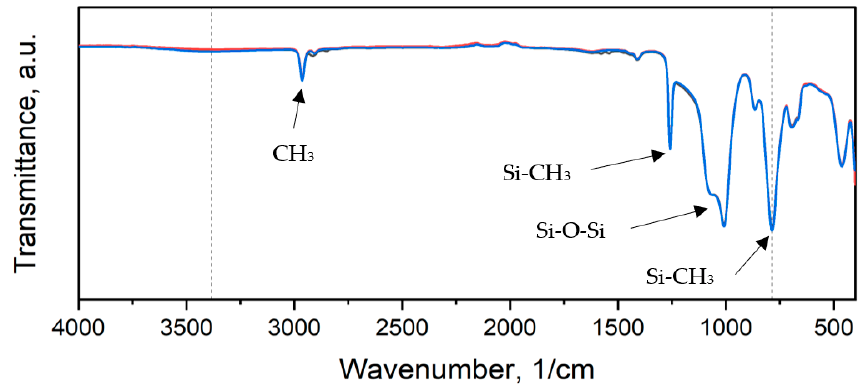
Figure 11. IR spectra of reference material: black—before aging, red—2 days of aging, blue—60 days of aging.